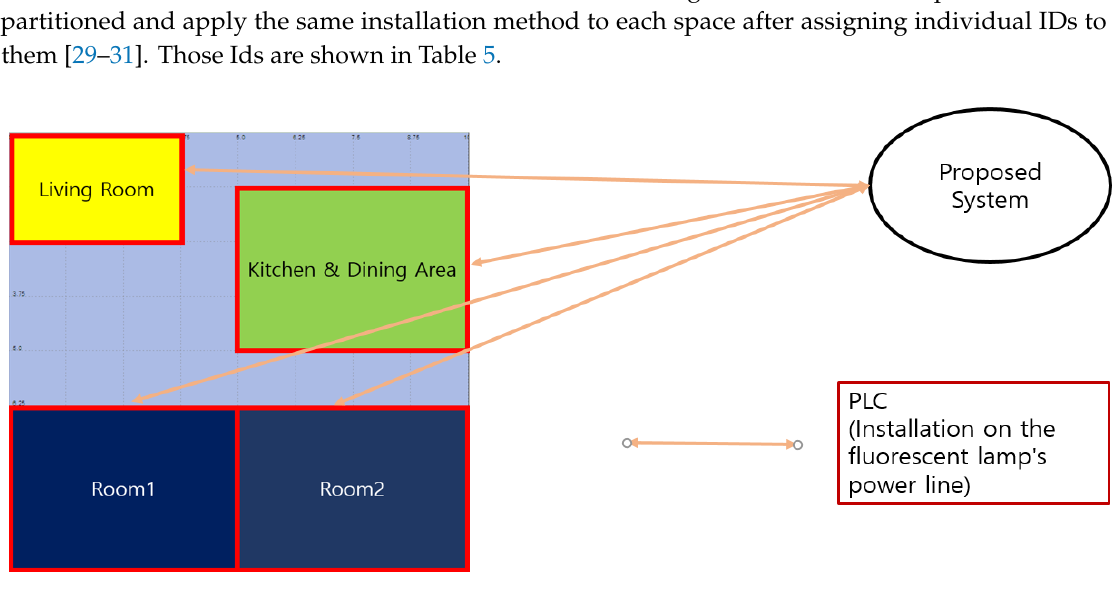
Figure 3. System flow map of the proposed system using OPNET Simulation. Table 5. Management IDs.